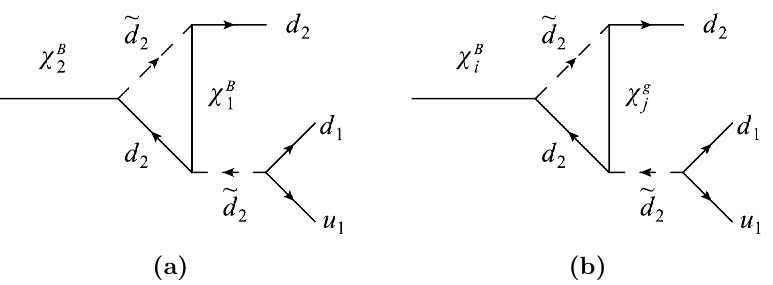
via virtual (cid:31) B . (b) Loop baryon number 2 1